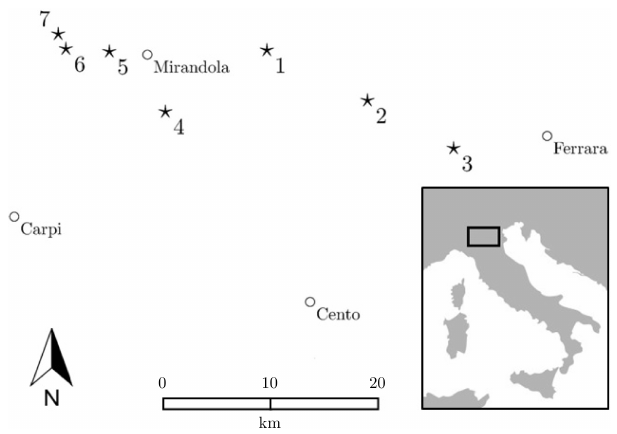
Figure 4. Geographic location of the 2012 Emilia seismic sequence (Italy). Stars indicate the epicentres; numbers indicate the order of fault activation.